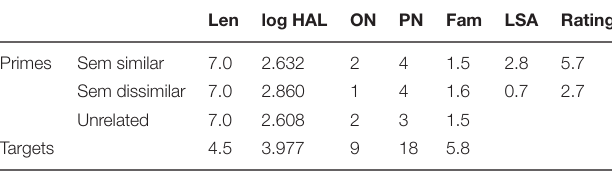
TABLE 1 | Attributes of targets and their